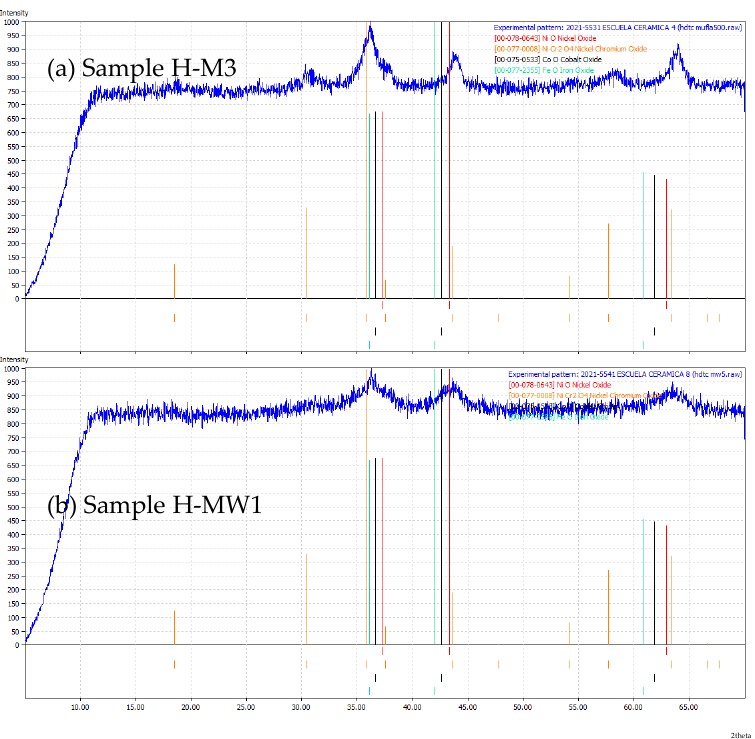
Figure 6. XRD of samples H-M3 ( a ) and H-MW1 ( b ) (red lines correspond to NiO XRD pattern (JCDPS 0780643), orange to NiCr 2 O 4 (JCDPS 0770008), dark blue to CoO (JCDPS 0750533) and light green to FeO (JCDPS 0772355)). Particle sizes were very low (under 100 nm) and there was no aggregation of particles, as shown in Figure 7 for sample H-MW1.